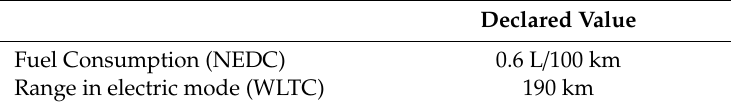
Table 25. BMW I3 fuel consumption.